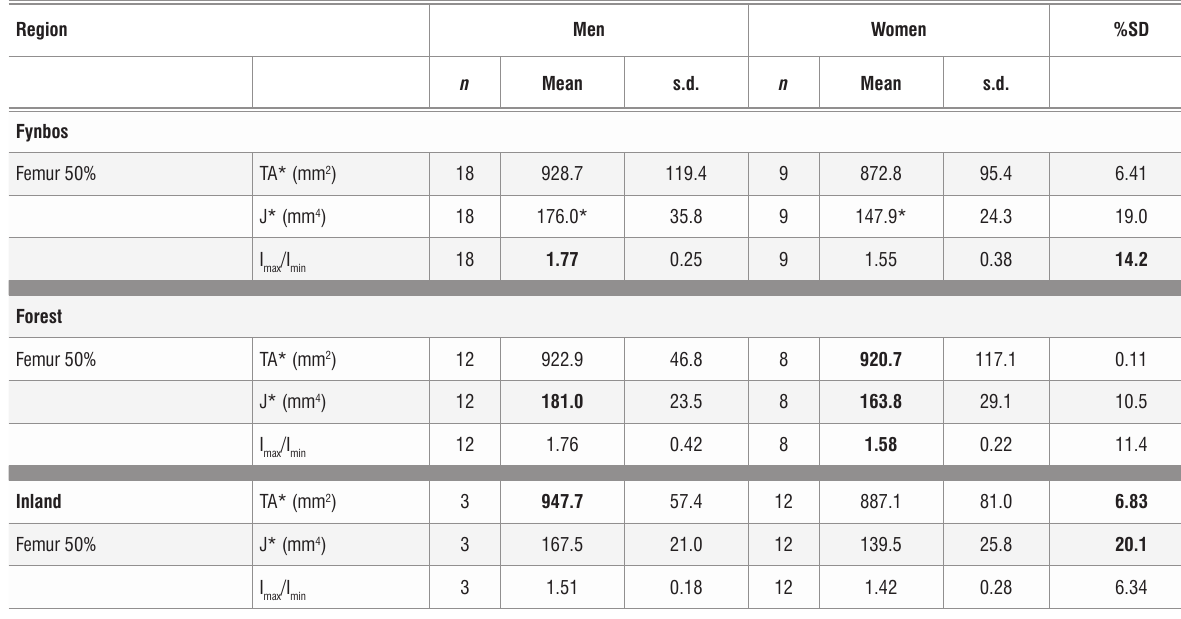
Bold =largest when comparing between